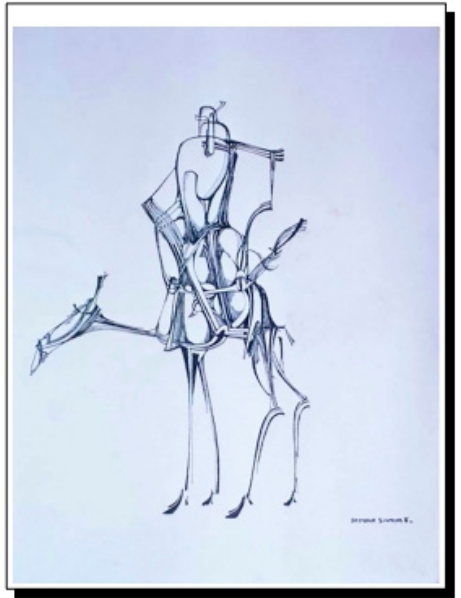
Figure 8. “Don Quixote I” by Seymour Simmons III; an example of “drawing as design”.